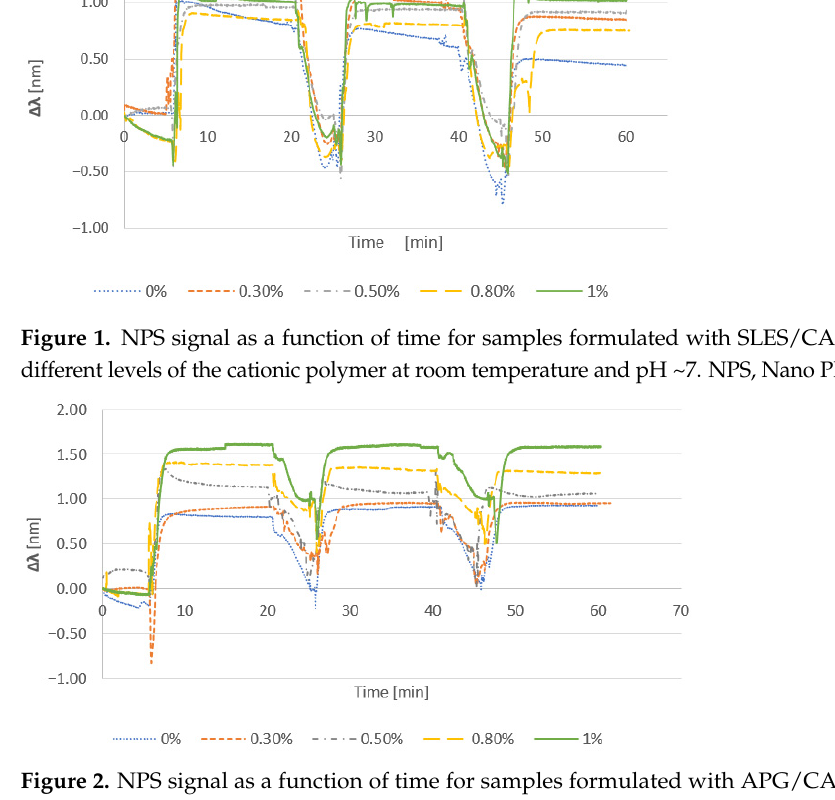
Figure 2. NPS signal as a function of time for samples formulated with APG/CAPB 12 wt. % and different levels of the cationic polymer at room temperature and pH ~7.